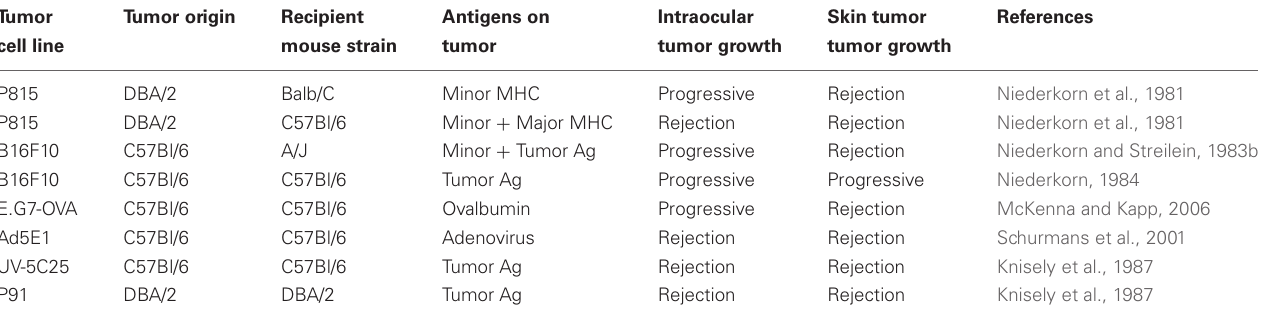
Table 1 | Transplantable intraocular tumor